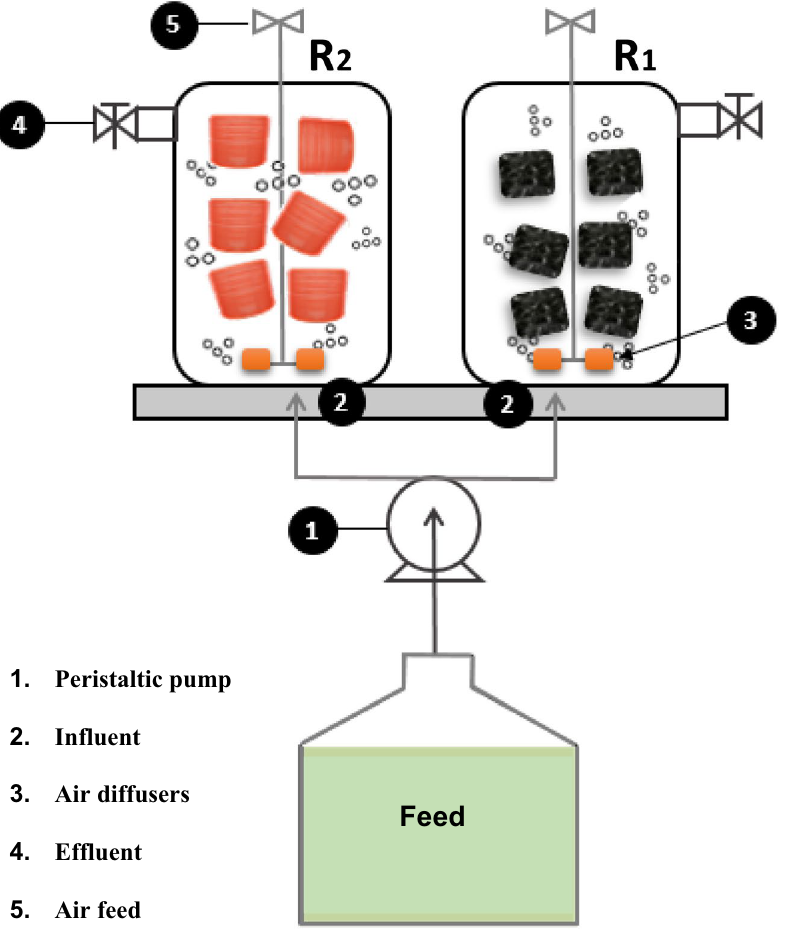
Figure 1. Schematic diagram of aerobic Fixed-film